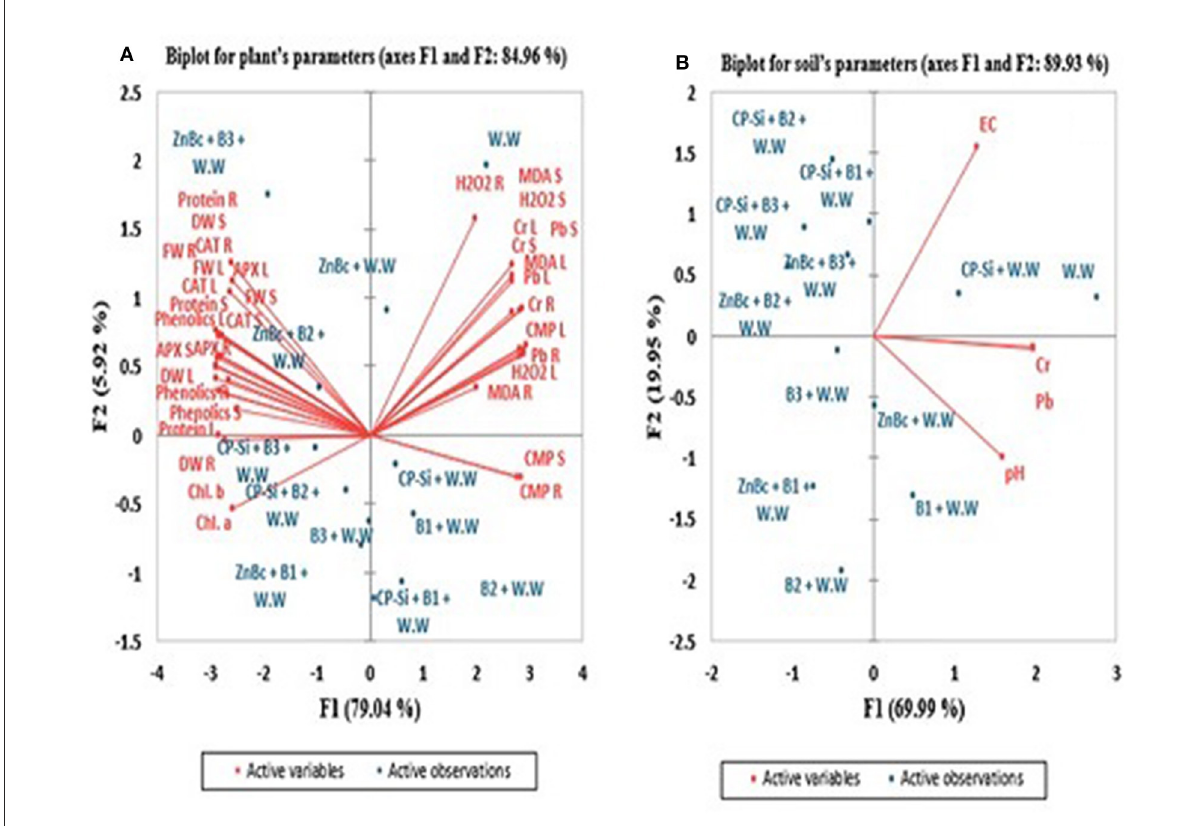
FIGURE5 Principal component analysis (PCA) of Solanum melongena L. plant and soil. F1 and F2 are PCA main factors/components which significantly contributed to generate PCA biplots. Active variables are (A) Chlorophyl a (Chl. a), Chlorophyl b (Chl. b), total Chromium (Cr), total Lead (Pb), Hydrogen peroxide (H 2 O 2 ), Malondialdehyde (MDA), Cell membrane permeability (CMP), Ascorbate peroxidase (APX), Catalase (CAT), proteins and phenolics and (B) parameters of soil such as total Cr and Pb, pH and Electrical conductivity (EC); however, R, S and L stands for root, stem and leaf respectively. Active observations are W.W-Wastewater; CP-Si gel-Chitosan polymerized silica gel; ZnBc-Zinc doped biochar; B1-Trichoccocuss sp; B2-Psuedomonas alcaligenes; B3-Bacillus